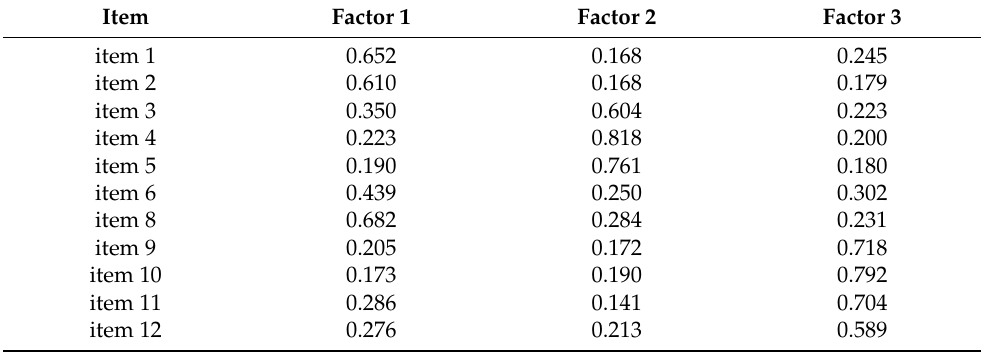
Table 4. Factor loadings extracted with the maximum likelihood method and rotated with the varimax method.